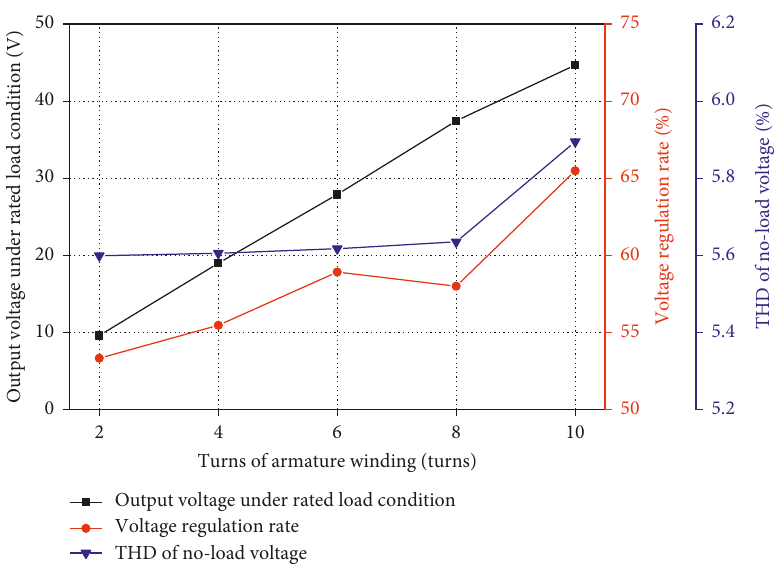
Figure 8: Variation curves of generator output performance with different armature winding